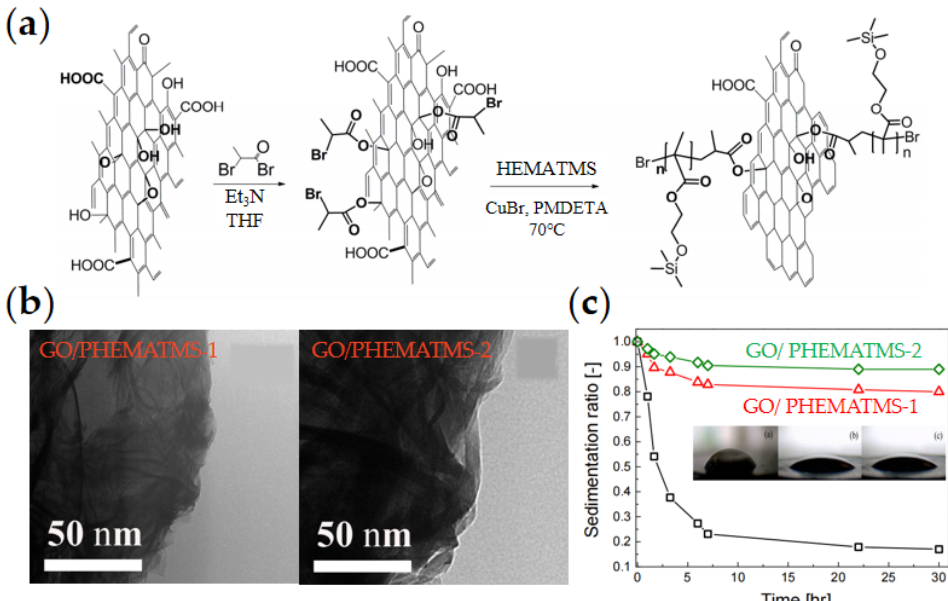
Figure 4. Schematic preparation of GO/PHEMATMS by SI-ATRP method ( a ) and corresponding TEM images of GO/PHEMATMS ( b ); ( c ) Sedimentation ratio of GO/PHEMATMS with different molecular weights, the molar masses of PHEMATMS-1 and PHEMATMS-2 are 12,600 g/mol and 20,400 g/mol, respectively [80].